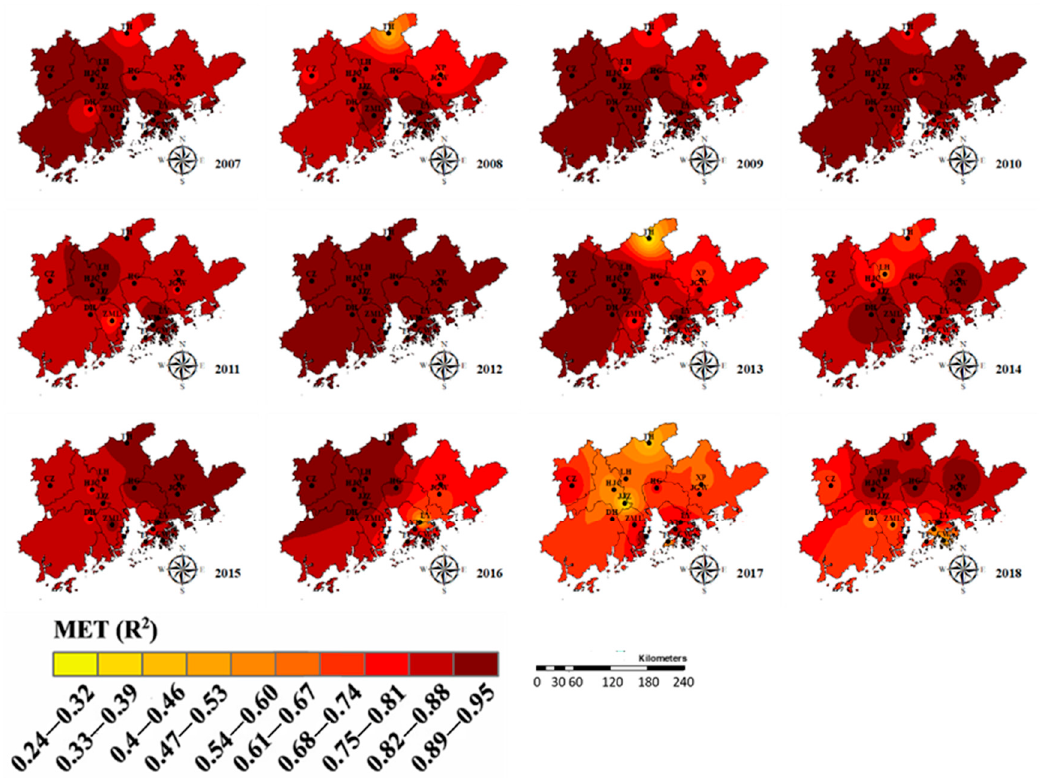
Figure 7. Interannual temporal and spatial variations of coefficients of determination (R 2 ) between the baseline of MDA8 and baselines of all meteorological variables (SSR, T, RH, u and v) from 2007 to 2018.